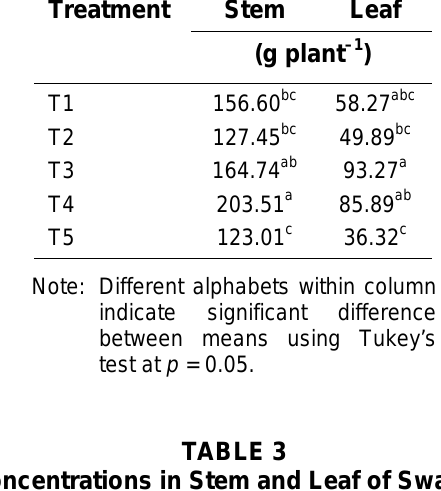
Dry Weight of Stem and Leaf of Swan at 90 DAP Stem